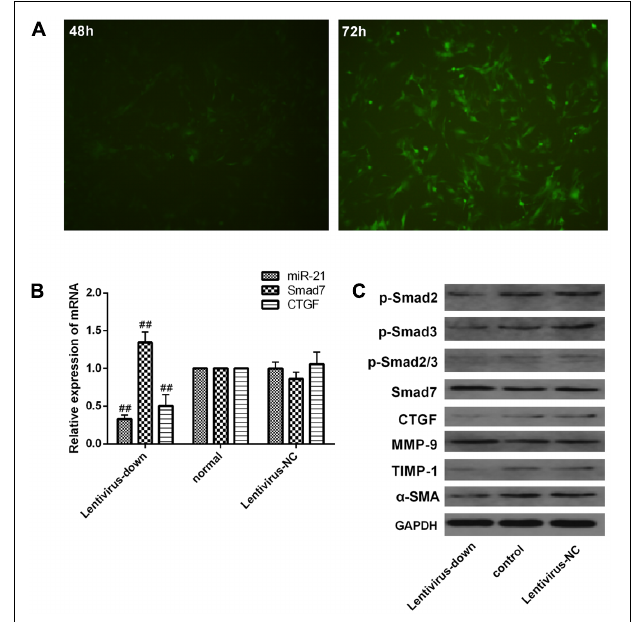
FIGURE 5 | Effects of CGA on the TGF- β 1/miR-21/Smad7 signaling pathway in LX2 cells after TGF- β 1 overexpression. (A–C) The mRNA levels were detected by real-time quantitative PCR. (D) The protein levels were assayed by western blotting. The data from three independent experiments are expressed as the means ± SD. ∗ P < 0.05 for lentivirus-up/TGF- β 1/CGA vs. lentivirus-up/TGF- β 1; ∗∗ P < 0.01 for lentivirus-up/TGF- β 1/CGA vs. lentivirus-up/TGF- β 1; # P < 0.05 compared with the normal group; ## P < 0.01 compared with the normal group.